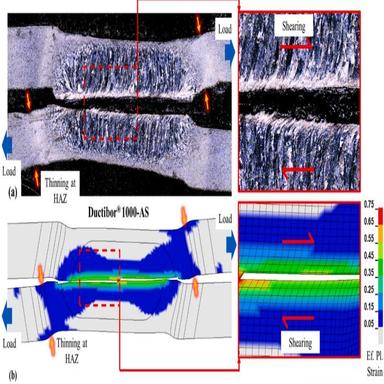
Post-failure analysis of interfacial failure in Ductibor® 1000-AS spot weld under shear loading. Contours are predictions of effective plastic strain.